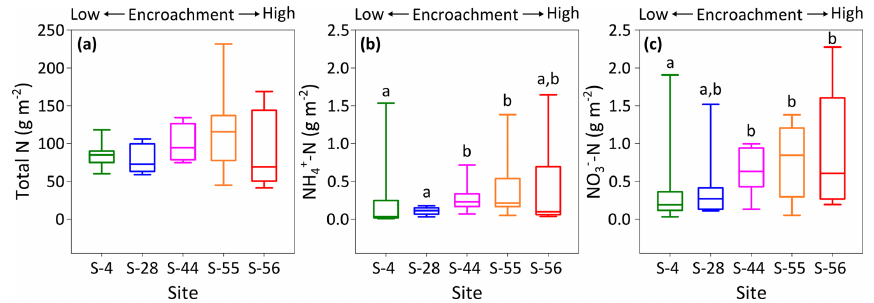
− N (b) , and NO − − N (c) concentrations (dry matter) weighted by relative area of inter-shrub to shrub Figure 6. Site-level total N (a) , NH + 4 3 cover for surface soil (top 10cm) along a gradient of shrub encroachment in the Santa Rita Experimental Range, AZ, US ( n = 9). Boxes denoted with alternative letters differ significantly from one another at p <0.05 (Dunn’s test).